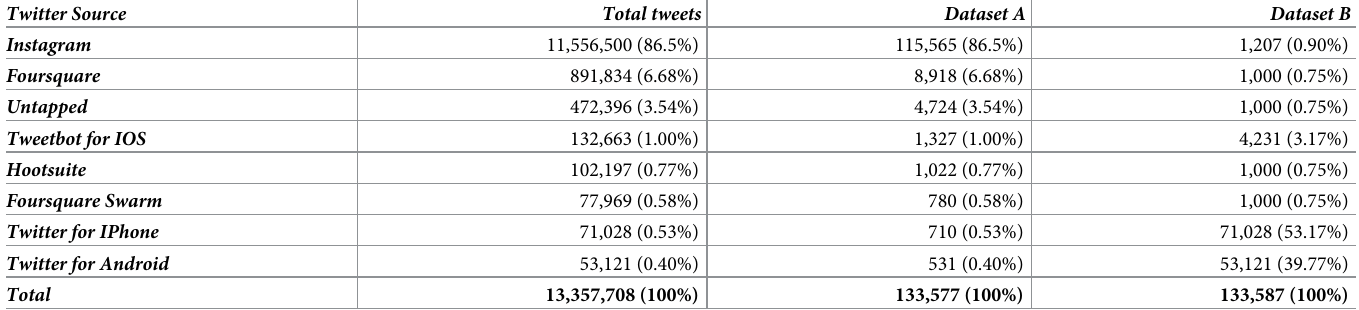
Table 1. Number of geotagged tweets per tweet source for the full dataset (Total tweets) and the two selected datasets, Dataset A and Dataset B. The table is ordered by descending order of the Total tweets column.